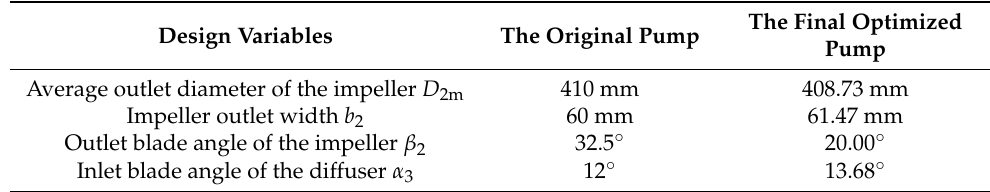
Table 12. Comparison of the impeller and diffuser parameters of the optimized pump with the original pump.